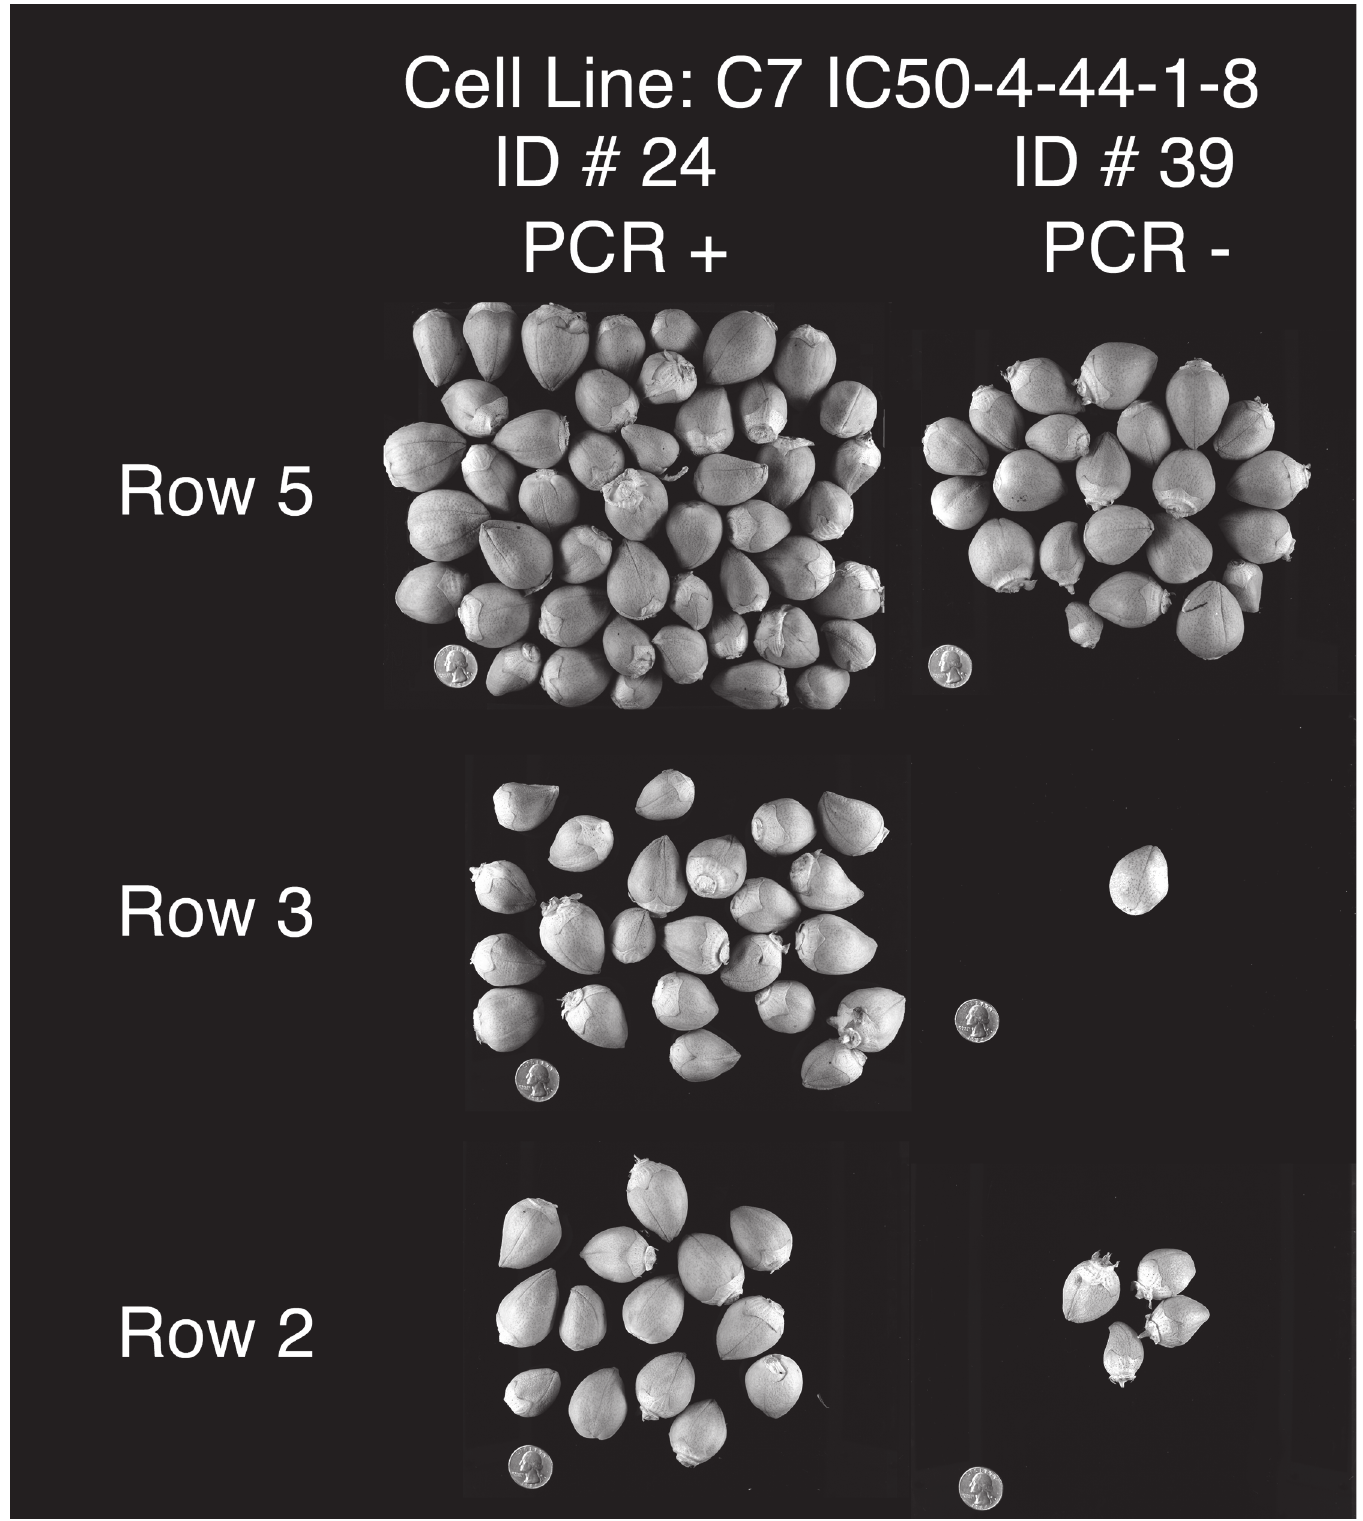
Fig 11. Boll accumulation on control and heat-treated cotton plants. Photograph of cotton bolls harvested from individual plants of plant line 24 (AtHSP101 plus) and plant line 39 (AtHSP101 minus) that were grown in a greenhouse with a 43°C/28°C day/night temperature regime. Paired plants (line